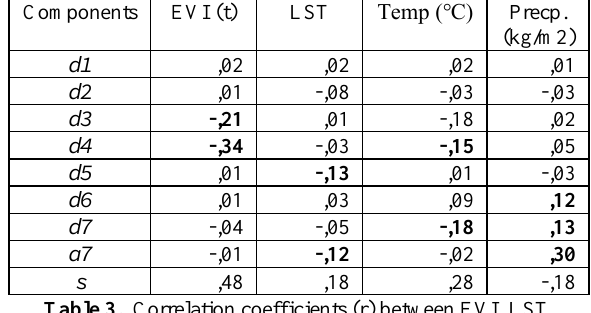
Table 3. Correlation coefficients (r) between EVI, LST,